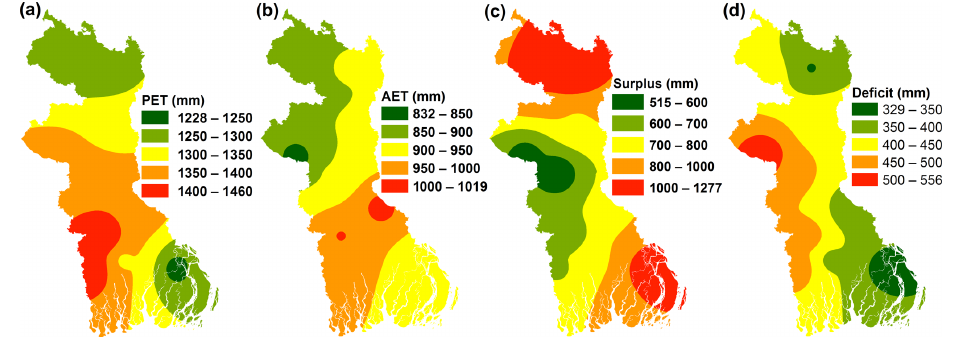
Figure 2. Distribution of mean annual (a) P ET , (b) A ET , (c) surplus, and (d) deficit of water in the study area during the hydrologic year 1981–1982 to 2012–2013. Table 2. Z statistic of MK or MMK of original time series, approximation, and different models P ET of DWT (the dominant components are shown in bold and the asterisks denote significance at a 5% level). Barisal Bhola Bogra